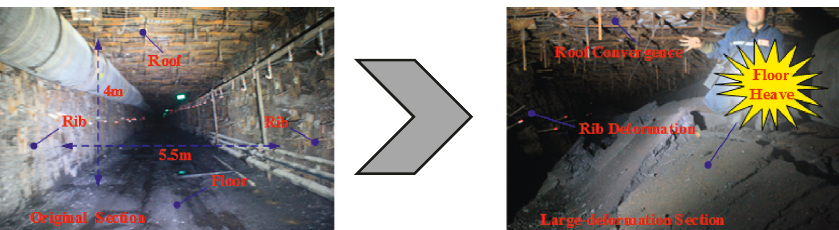
Figure 9: Deformation characteristics of the 19.5m stiff coal-pillar entry retaining [39]. The entry experiences the whole hard roof activation above the